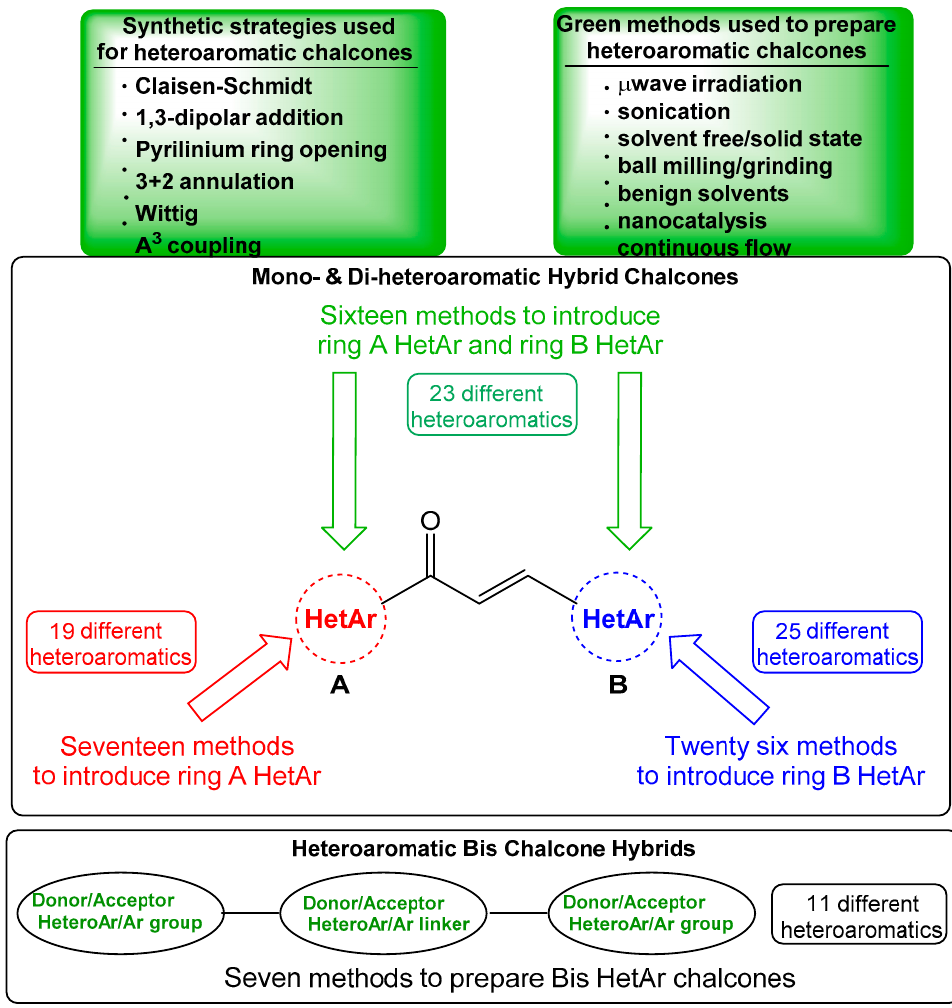
Figure 3. Heteroaromatic hybrid chalcone construction.